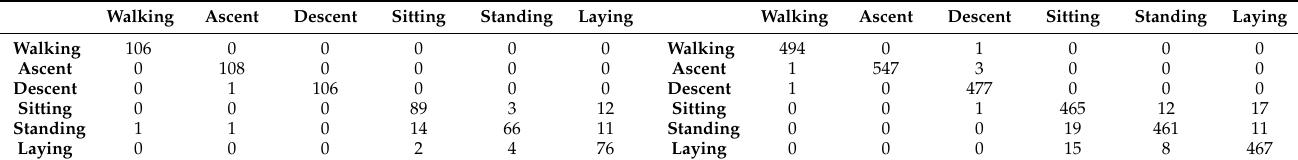
Table 6. Confusion matrix of UCI HAR- ResNet50 (initial results—left, final